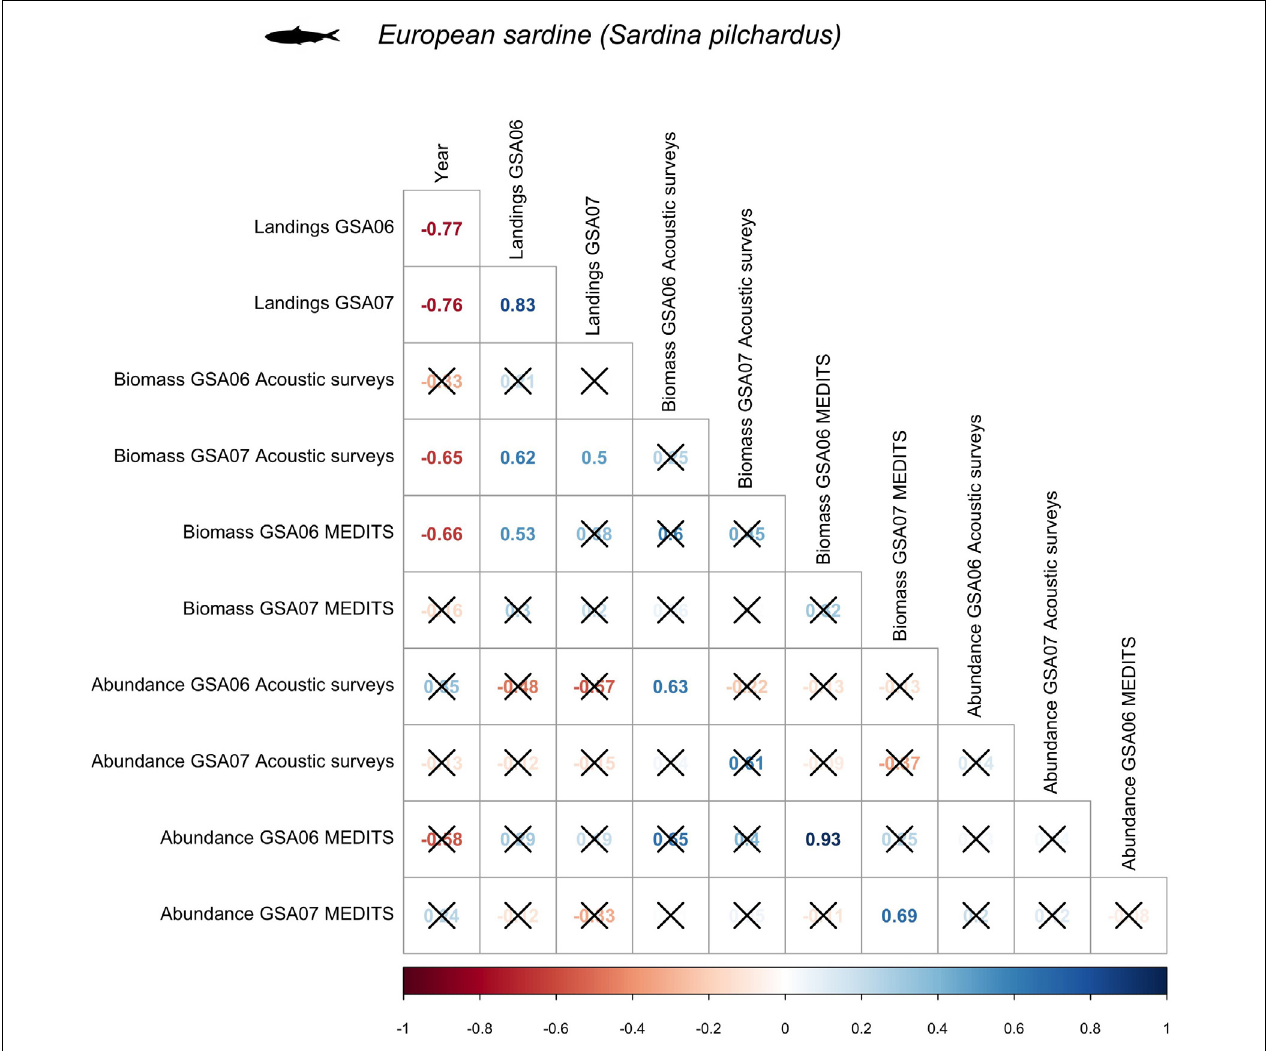
FIGURE 3 | Spearman’s correlation for European sardine ( Sardina pilchardus ) among biomass and abundance collected during acoustic (ECOMED, PELMED and MEDIAS) and demersal (MEDITS) surveys, as well as official countries landings, in the Geographical Sub-Area 06 and 07 from 2003 to 2016.